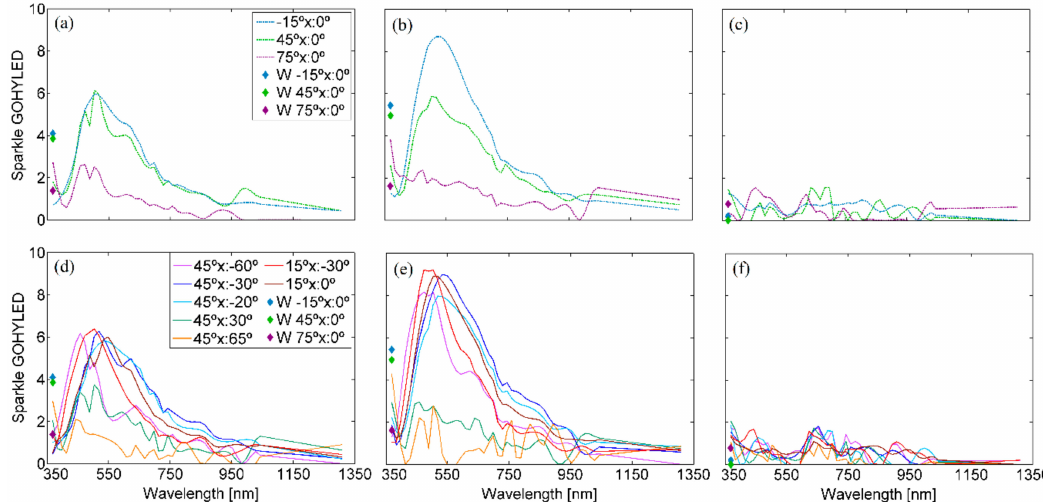
Figure 6. GOHYLED sparkle spectra of ( a ) a pearlescent, ( b ) a metallic and ( c ) a solid sample for the − 15 ◦ x: 0 ◦ , 45 ◦ x: 0 ◦ and 75 ◦ x: 0 ◦ geometries of sparkle, and GOHYLED sparkle spectra of ( d ) a pearlescent, ( e ) a metallic and ( f ) a solid sample for the geometries of spectral / colorimetric measurements 45 ◦ x: − 60 ◦ , 45 ◦ x: − 30 ◦ , 45 ◦ x: − 20 ◦ , 45 ◦ x: 30 ◦ , 45 ◦ x: 65 ◦ , 15 ◦ x: − 30 ◦ and 15 ◦ x: 0 ◦ . The sparkle grade related to the white LED cluster (W) is represented by diamond markers ( − 15 ◦ x: 0 ◦ in blue; 45 ◦ x: 0 ◦ in green; 75 ◦ x: 0 ◦ in